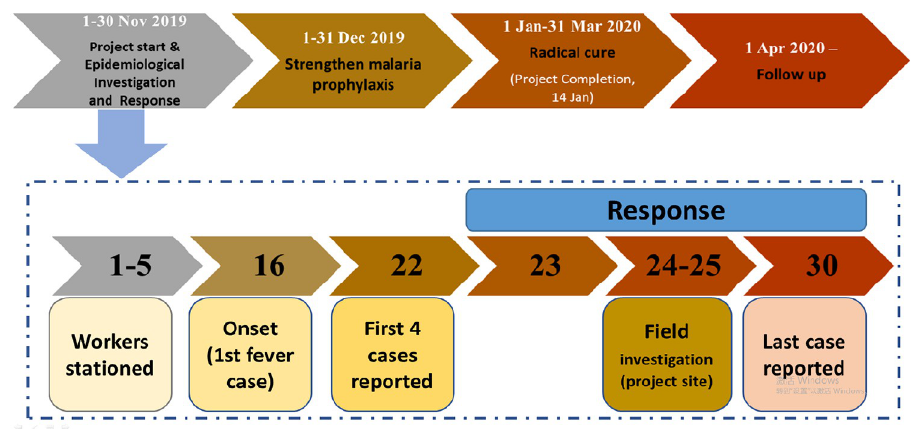
Fig 2. Process of the public health response to the border-spill malaria